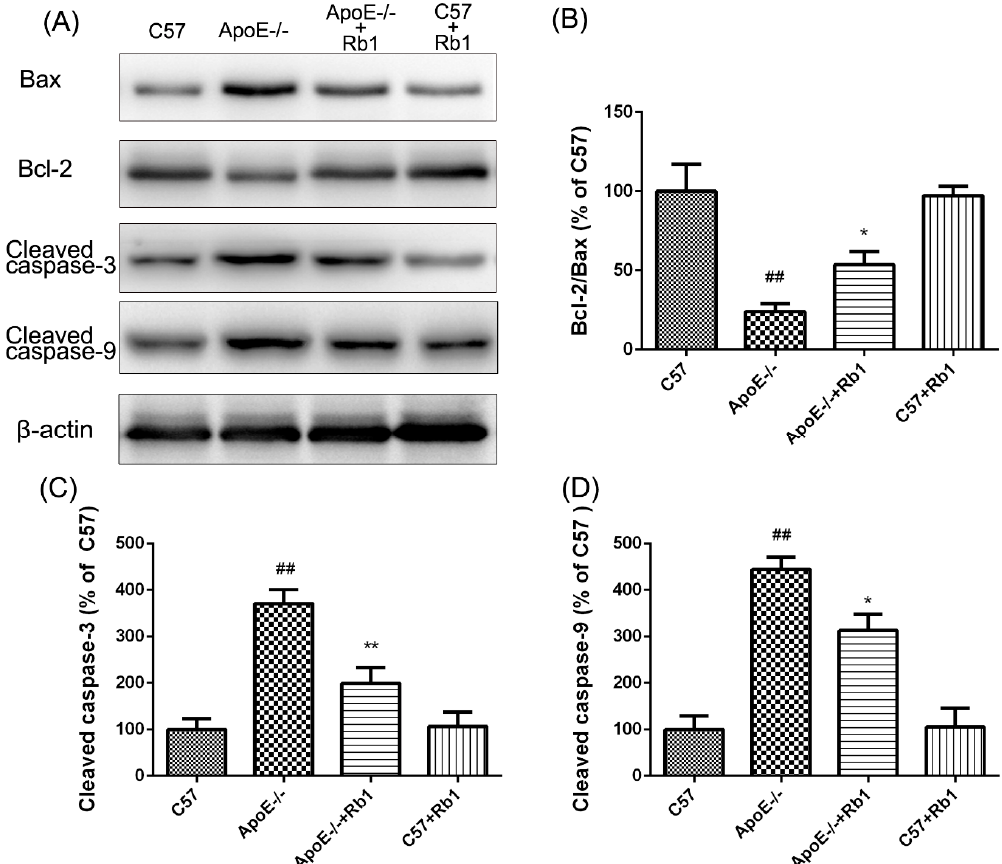
Figure 6. Rb1 regulated apoptosis-related protein expression in the aorta of ApoE-/- mice. ( A ) The levels of Bcl-2/Bax, cleaved caspase-3 and cleaved caspase-9 were determined by western blot analysis. ( B ) Quantitative analysis of the Bcl-2/Bax expression ratio. ( C ) Quantitative analysis